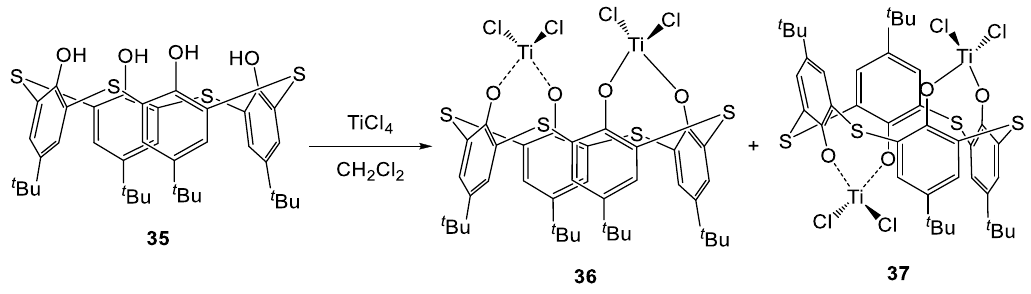
Table 12. Polymerization of ethylene catalysed by 36 and 37 /MAO systems [21].